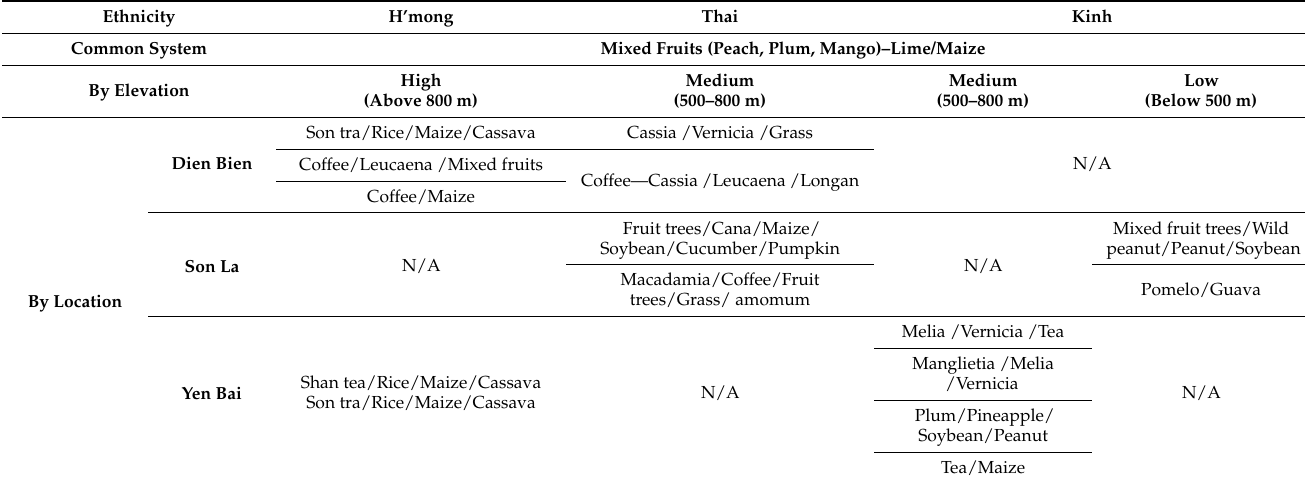
Table 4. Preferred agroforestry options identified by three ethnic groups and local contexts. Ethnicity H’mong Common System Mixed Fruits (Peach, Plum, Mango)–Lime/Maize By